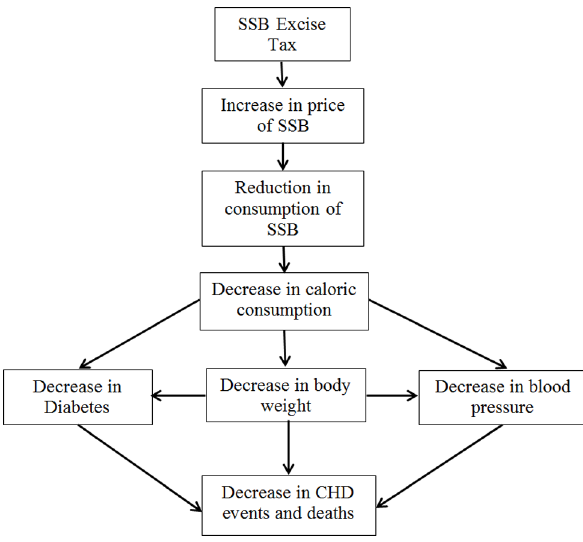
Figure 1. Framework for the impact of an SSB tax on health outcomes.